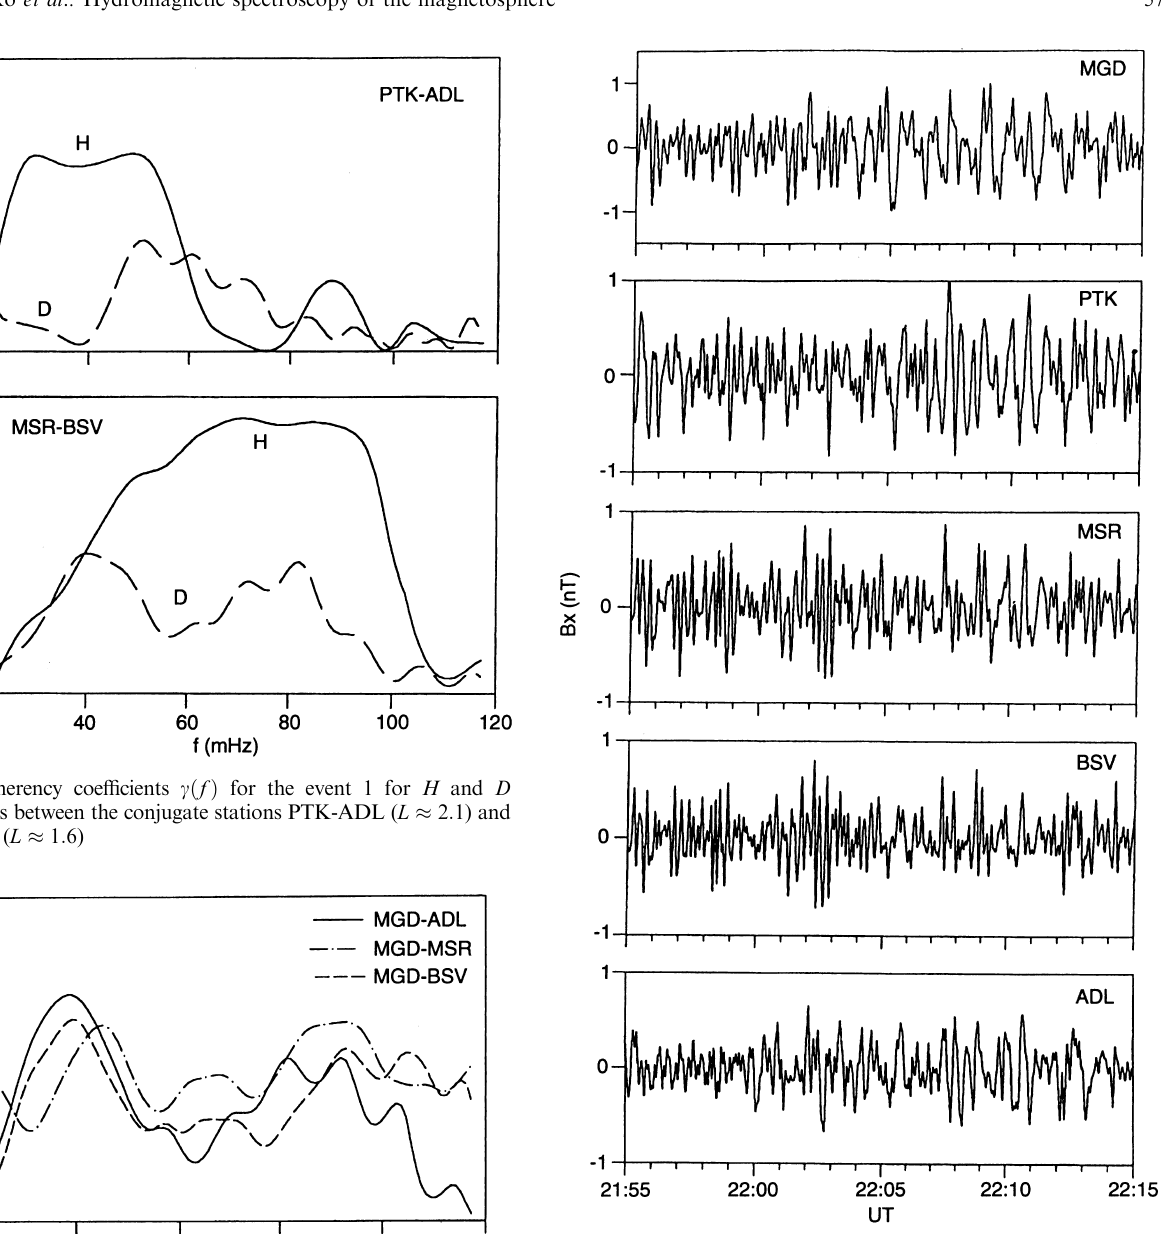
Fig. 6. Band-pass filtered in the range 10–150 mHz magnetograms of H -component of pulsations, recorded on October 13, 1992, 21:55– 22:15 UT